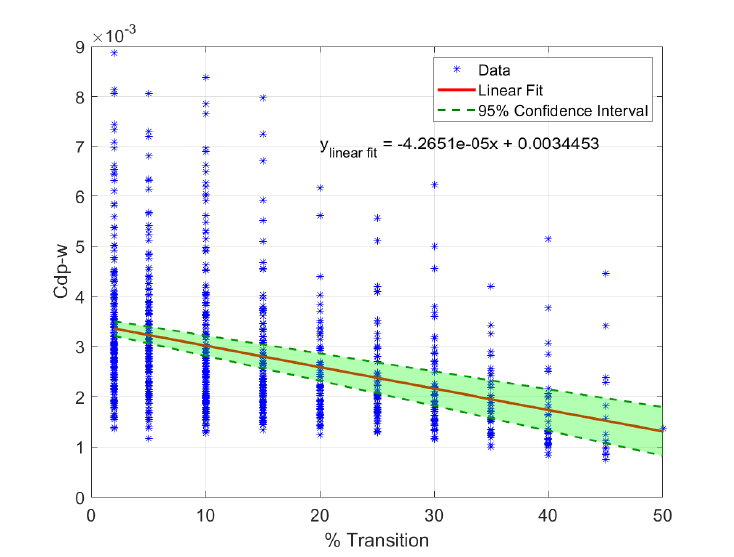
Figure 4. Form drag penalty model.